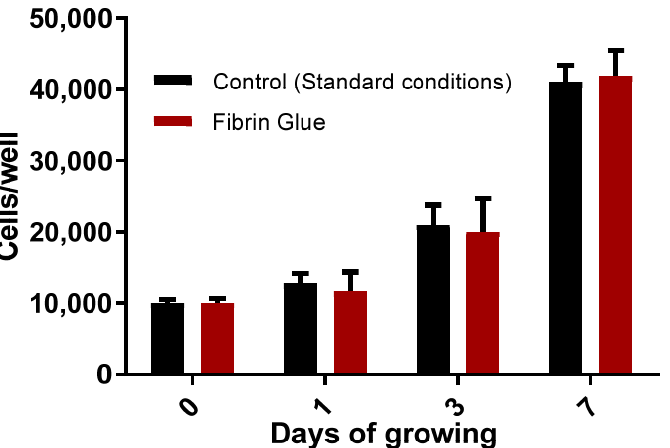
Figure 2. The proliferation of human DPSC grown in fibrin gel and in standard conditions (con- trol). X-axis: days after passaging. Y-axis: the quantity of cells per well. Values are shown as means ± standard error. Table 1. Immunophenotype of DPSC embedded in fibrin glue and grown in standard